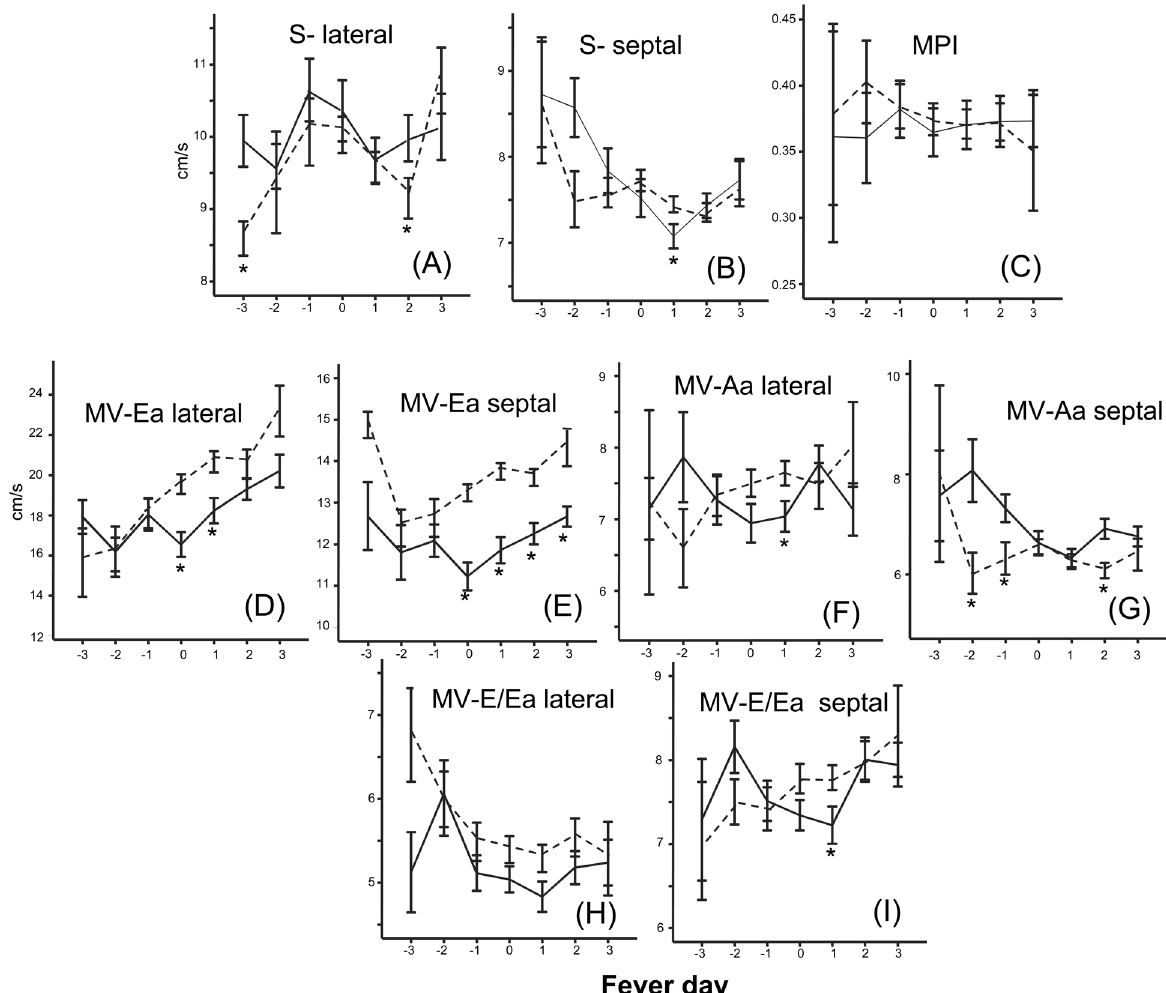
Fig 3. Tissue Doppler image of LV functions by fever day. Left ventricular lateral (A) and septal S wave (B), LV mean performance index (MPI) (C), lateral (D) and septal (E) annulus movement during early diastole, lateral (F) and septal (G) annulus movement during late diastole, and lateral (H) and medial (I) E/Ea ratios of dengue fever (dotted line) and dengue hemorrhagic fever (solid line) cases over the course of the illness. Fever day 0 denotes day of defervescence. * different from DF ( P < .05). The numbers of cases were: fever-day -3 (DF 4, DHF 5), fever-day-2 (DF 13, DHF 9), fever-day-1(DF 43, DHF 26), fever-day-0(DF 104, DHF 56), fever-day+1(DF 119, DHF 62), fever-day+2(DF 70, DHF 60), fever-day+3(DF 13, DHF